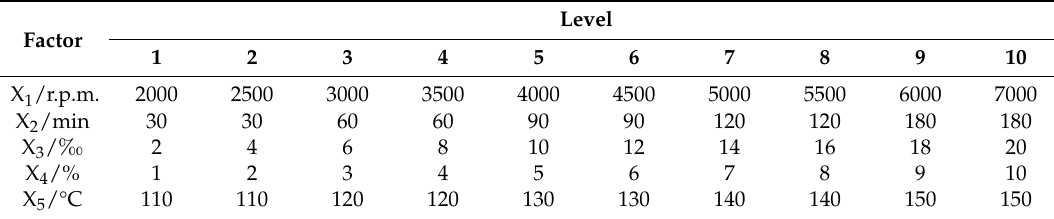
Table 4. Test design factor